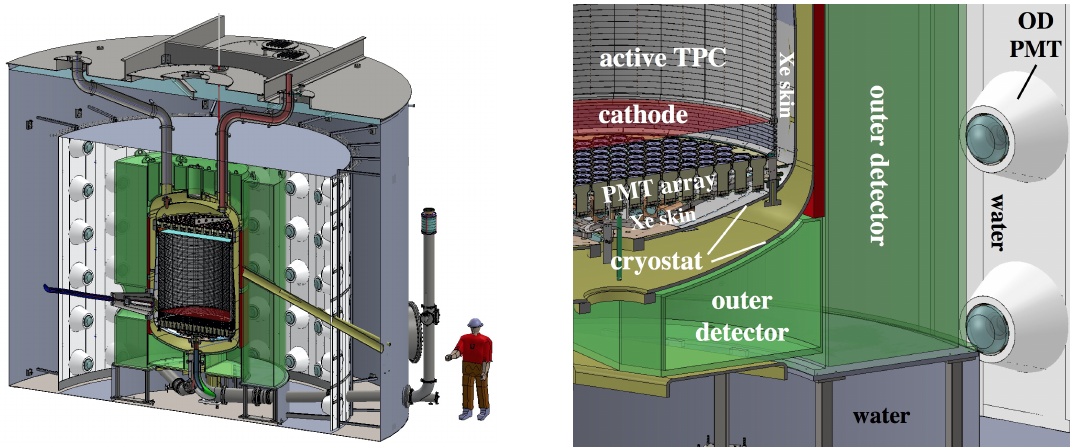
Figure 3. ( Left ) Schematic diagram of theLUX-ZEPLIN (LZ) detector. The LXe TPC is surrounded by the outer detector tanks (green) and light collection system (white), all housed in a large water tank (blue-grey). Conduits deliver services to various detector systems: PMT and instrumentation cables (top and bottom, red); cathode high voltage (lower left with cone); purified LXe (bottom centre, green); neutron beam conduit (right, yellow). ( Right ) Expanded view of the lower right corner. The xenon skin region is viewed by a separate set of PMTs (not visible